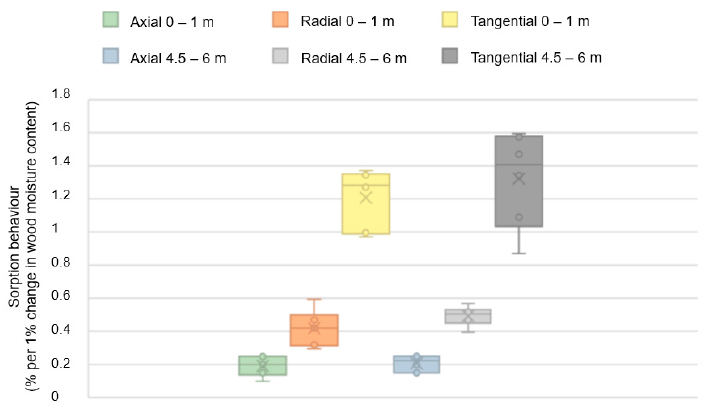
Figure 8. Sorption behavior in the axial, radial, and tangential direction of Paulownia samples extracted at 0–1 m and 4.5–6 m from the tree stem.